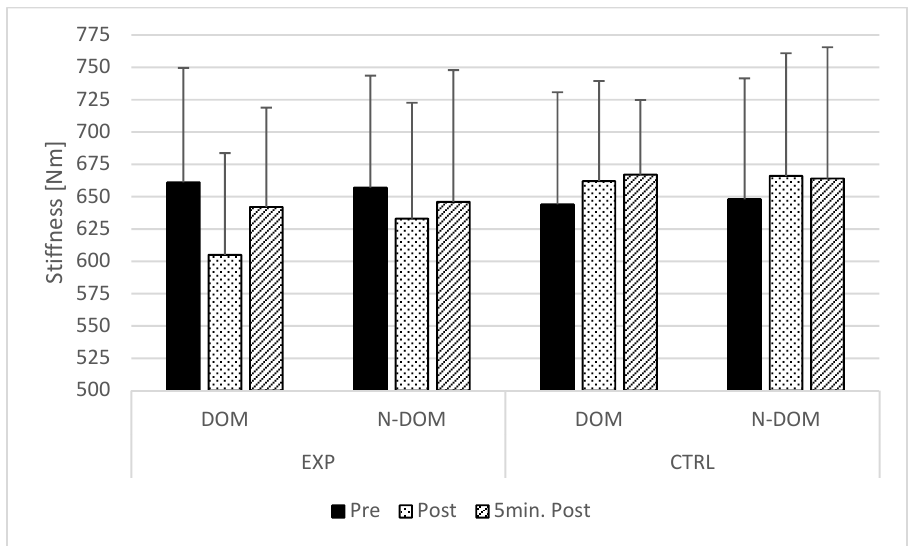
Figure 2. Comparisons of pre- and post-percussion massage Achilles tendon stiffness. DOM–dominant limb; N-DOM–nondominant limb; EXP–experimental condition; CTRL–control condition.